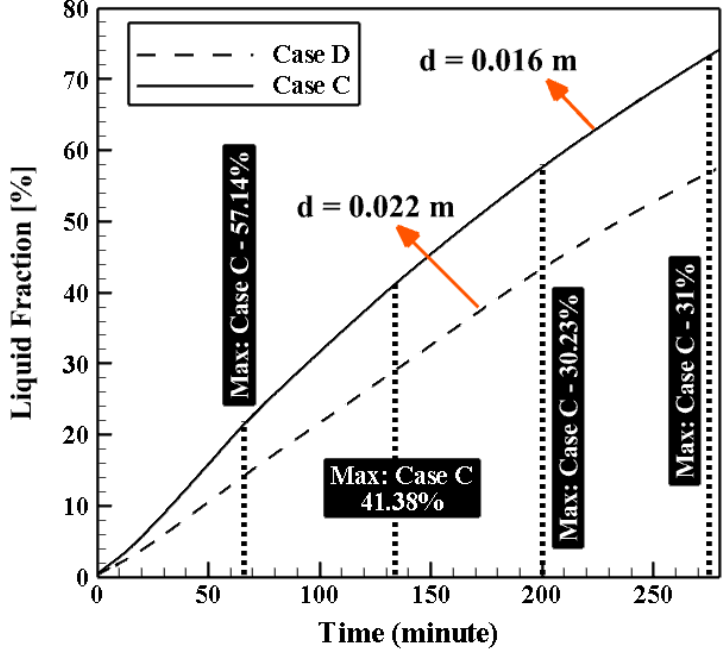
Figure 14. Temporal evolution of the liquid fraction (LF) for cases C and D.